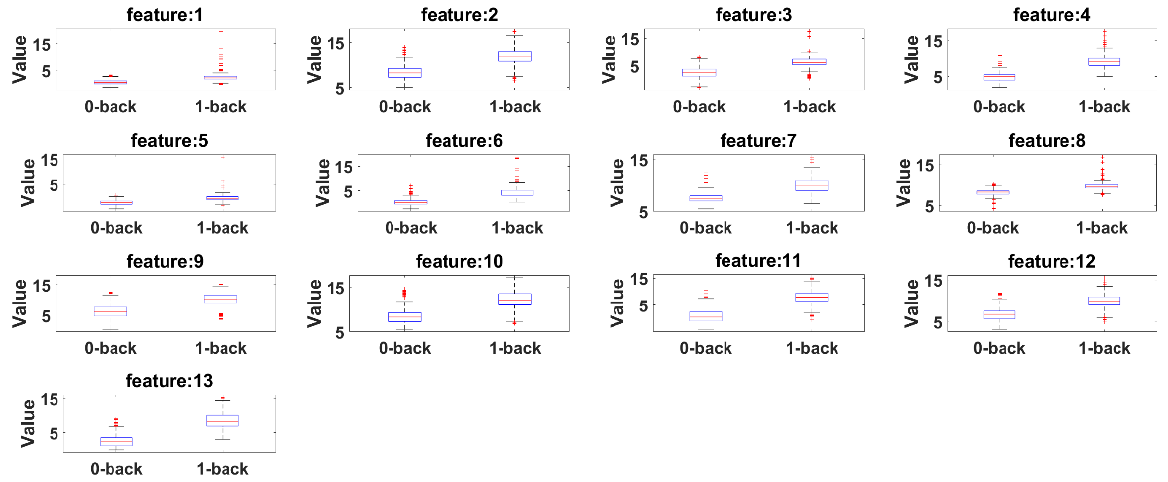
Figure 15. Boxplot of 0-back and 1-back for eyeT features.